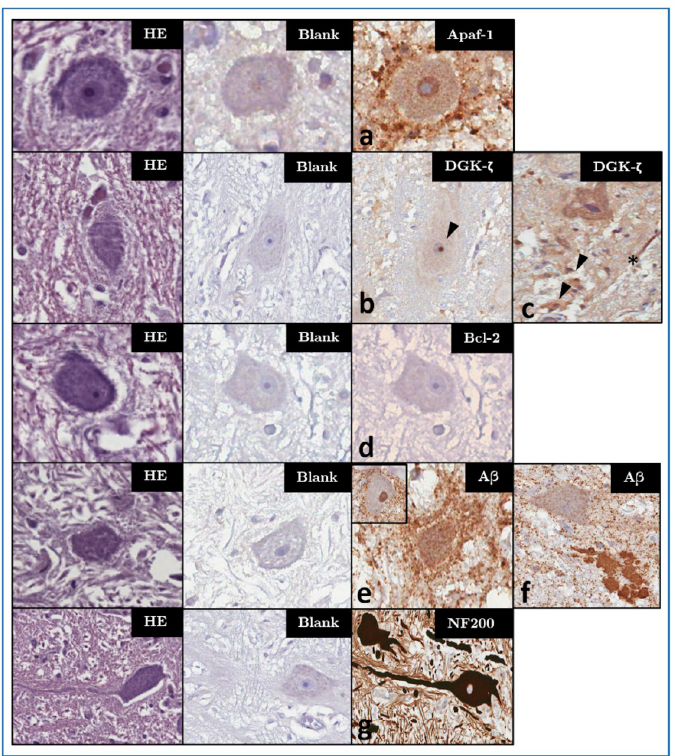
Fig 2. Haematoxylin-eosin/HE (left column), blank control/CTRL (middle column) and IHC patterns (right columns) for the investigated markers—magnification: 400x. Panels marked a-f represent characteristic IHC patterns for each marker: (a) Apaf-1-IR in both neuronal cytoplasm and, unlike in most other examined animals, in the nucleus of ID319. (b) Nucleolar DGK- z -IR (arrowhead) in the VCN of a younger adult dolphin without brain lesions (ID146) as compared to (c) its cytoplasmic appearance in the VCN of a bycaught, older adult (ID203). In this animal, multifocal cytoplasmic IR in glial cells (arrowheads), as well as streaks of IR in the neuropil (asterisk) are apparent. (d) Lack of Bcl-2-IR in the VCN of a younger adult dolphin (ID89), representative of most adults. (e) Perineuronal enhancement of glial A β -IR in the VCN of a bycaught, hypoxic dolphin (ID203). (f) A β -IR marking a coalescing extracellular plaque between the VCN and superior olivary complex of older adult (ID319). An adjacent neuron shows light disseminated granular IR in its cytoplasm, but not in the nucleus, as in the VCN of most investigated adult dolphins < 30 y.o. (inset in e). (g) Intense NF200-IR of the dendritosomatic and axonal cytoskeleton of VCN neurons (ID89, representative of all investigated animals).